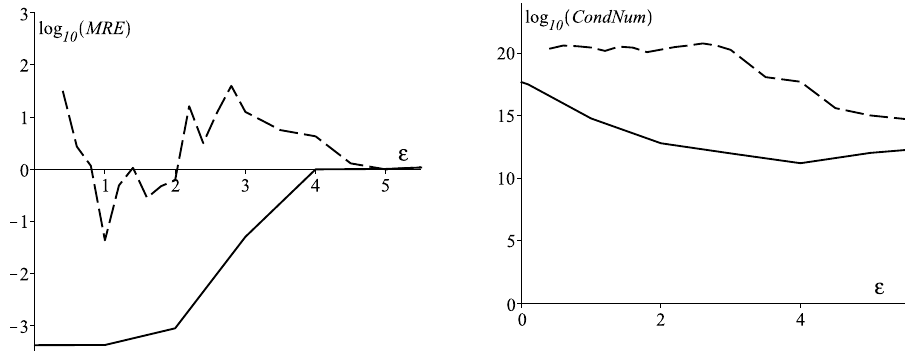
Figure 8: Influence of the shape parameter on the accuracy – left, and condition number – right. Stable basis – solid line, Gaussian kernel – dash line. Results for the BVP on the triangular domain with corner cut-out with boundary conditions given by Eq. (28) implemented